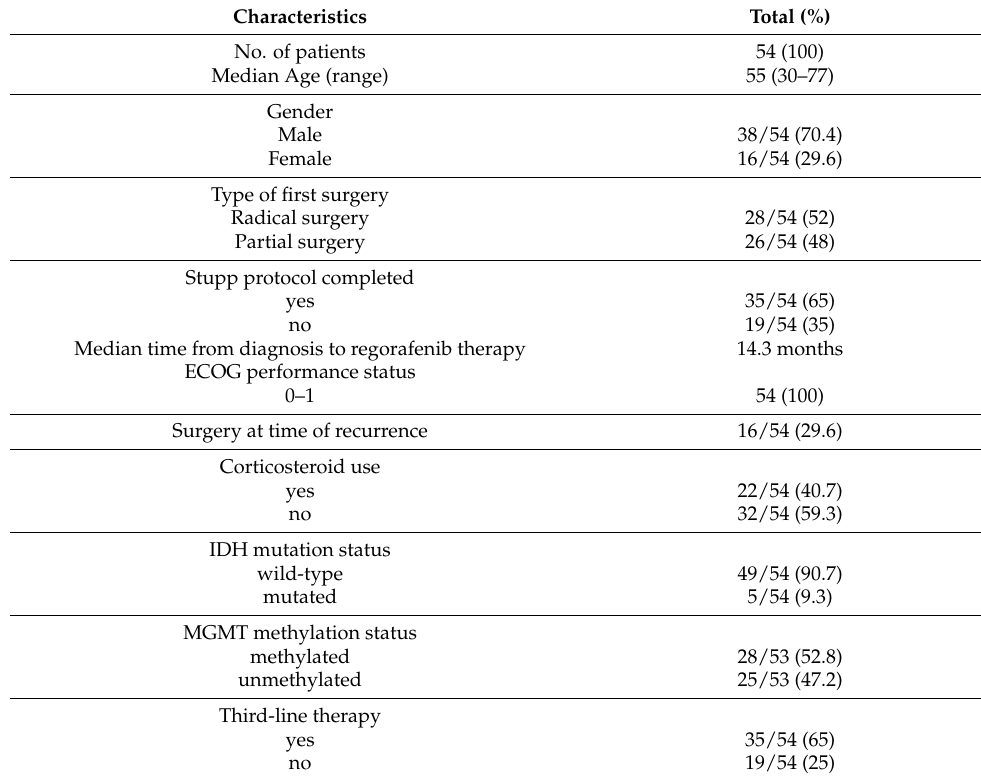
Figure 1. Flow-chart of the study. Table 1. Characteristics of the enrolled